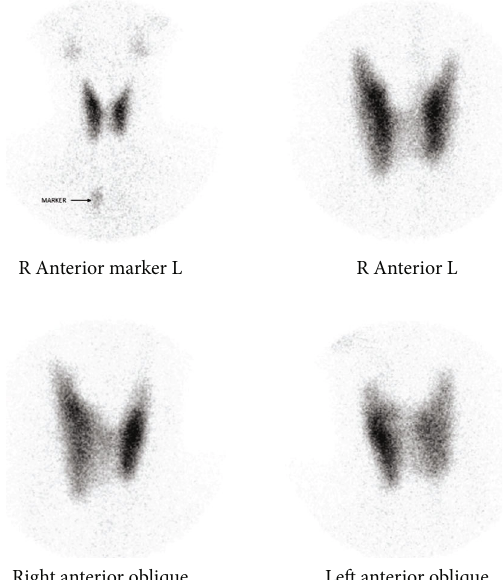
Figure 2: Tc-99m pertechnetate thyroid scintigraphy (thyroid scan) showing absence of avid uptake of both thyroid glands with no ectopic thyroid tissue and no